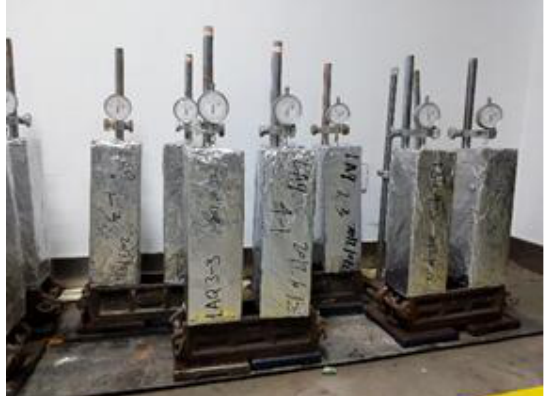
Figure 2. Shrinkage